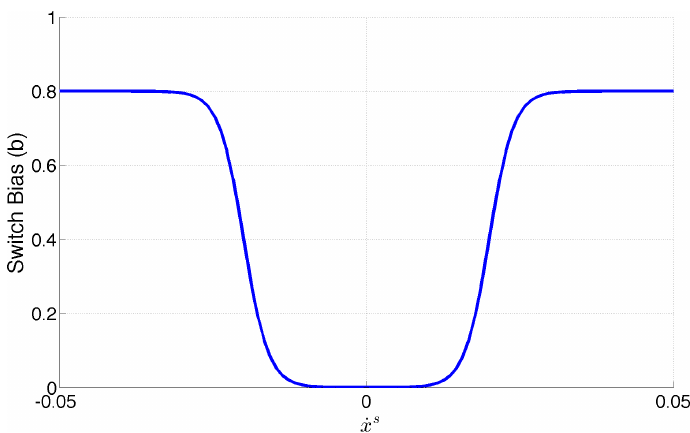
Figure 6. The aSLDS transition